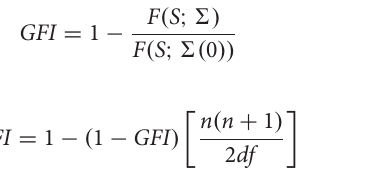
where F 0 is the value of the difference function; df is the degree of freedom. The smaller RESEA is, the better the fitting effect between the representative data